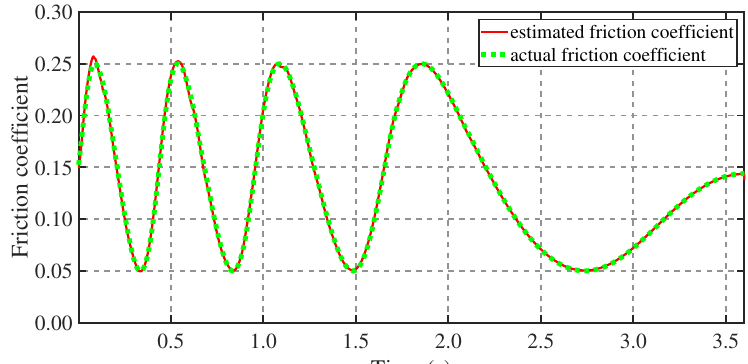
Figure 12. Trajectory of the estimated friction coefficient when the robot slides on terrain with a variable friction coefficient.